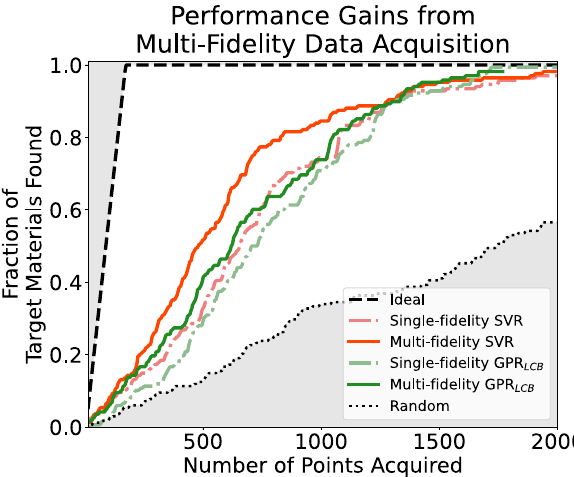
Figure 7. Simulated performance of various campaigns when both DFT and experiment data were acquired during runs. The results of all campaigns are combined in one figure. N experiment on the x-axis corresponds to the experimental acquisition budget. Discoveries on the y-axis correspond to the fraction of ideal materials discovered from the search space. The random acquisition and ideal acquisition baselines are also labeled in the